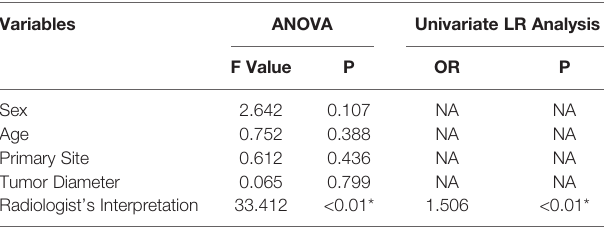
TABLE 3 | The selection of clinical risk factors for ETE by ANOVA and univariate LR analysis. Variables